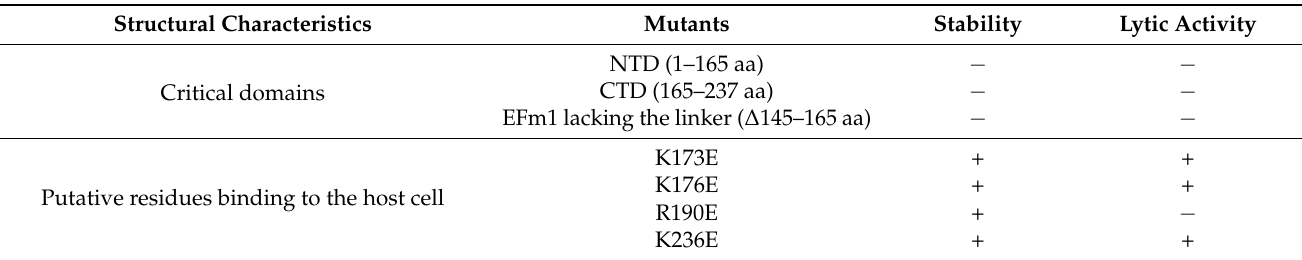
Table 3. Summary of the domains and residues identified as being important for the stability and lytic activity of EFm1 in this study.